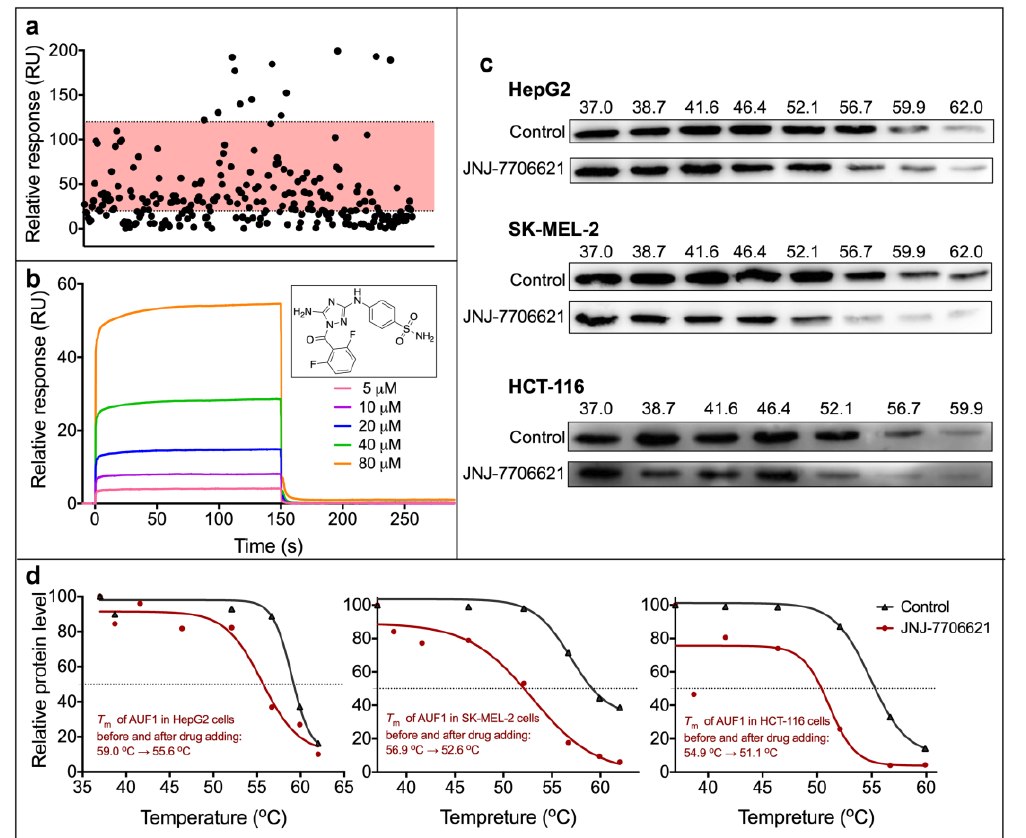
Figure 2. Screening of AUF1’s binder by SPR assay and the target validation. ( a ) Pre-screening from the commercially available compounds library by SPR assay. The concentration of compounds was 50 μ M. Compounds with a RU value ranging from 20 to 120 (red region) were selected for further kinetic analysis. ( b ) The sensorgram and structure of compound JNJ-7706621 in the kinetic analysis. ( c ) Results of the cellular thermal shift assay (CETSA) of AUF1 in three cell lines. Cells were treated with JNJ-7706621 at 1, 3.5, and 6 μ M, respectively. From upper to bottom : Western blot graph in HepG2, SK-MEL-2, and HCT-116 cells, respectively. ( d ) Melting curves from the CETSA experi- ments. The curves were obtained by GraphPad Prism 8.0 and fitted with a sigmodal mode to get the melting temperatures. From left to right: curves and melting temperatures ( T m ) in HepG2, SK-MEL- 2, and HCT-116 cells.